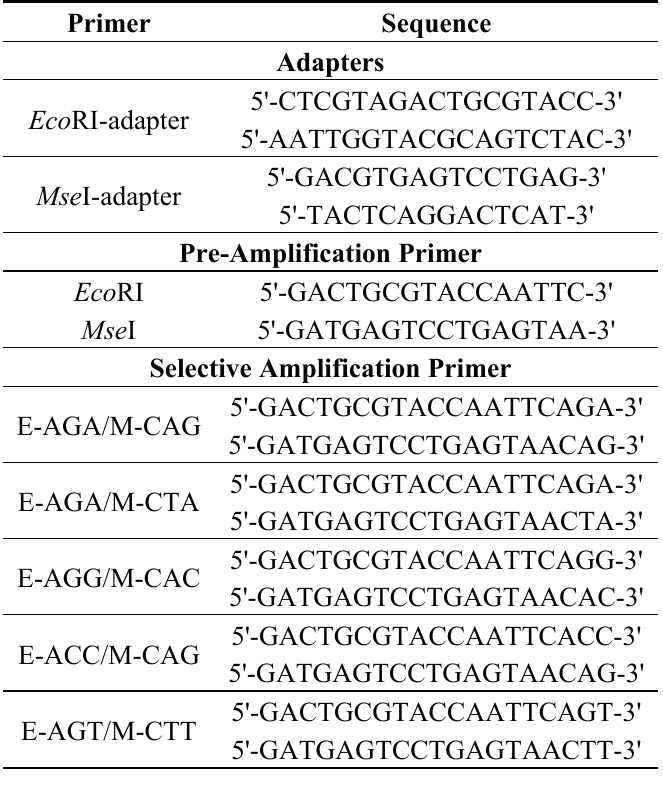
Figure 6. Map of the Coilia nasus collection sites. Table 5. Adaptor and primer sequences used in AFLP